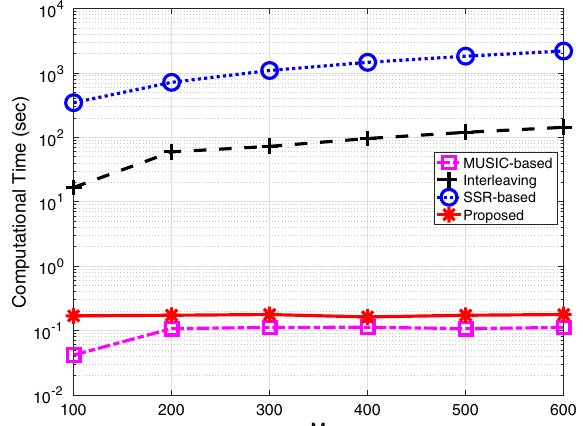
Fig. 9 DOA estimation accuracy comparison with differnet number of OFDM